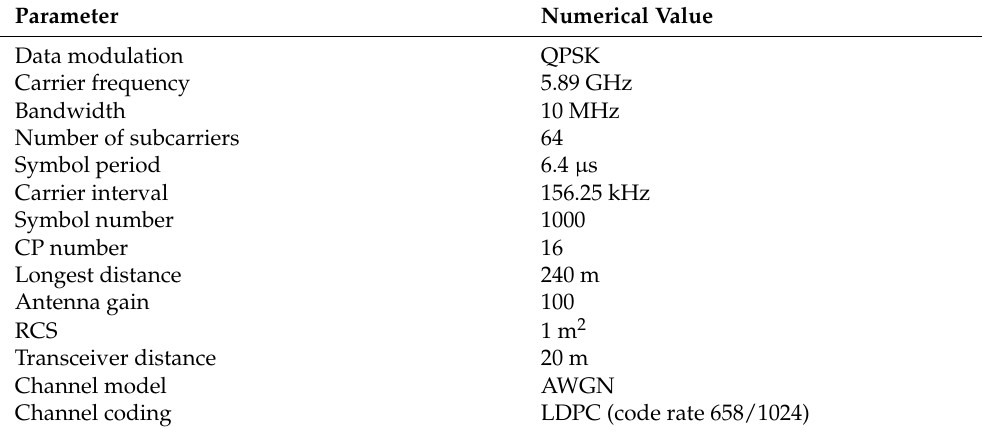
Table 1. Basic parameter